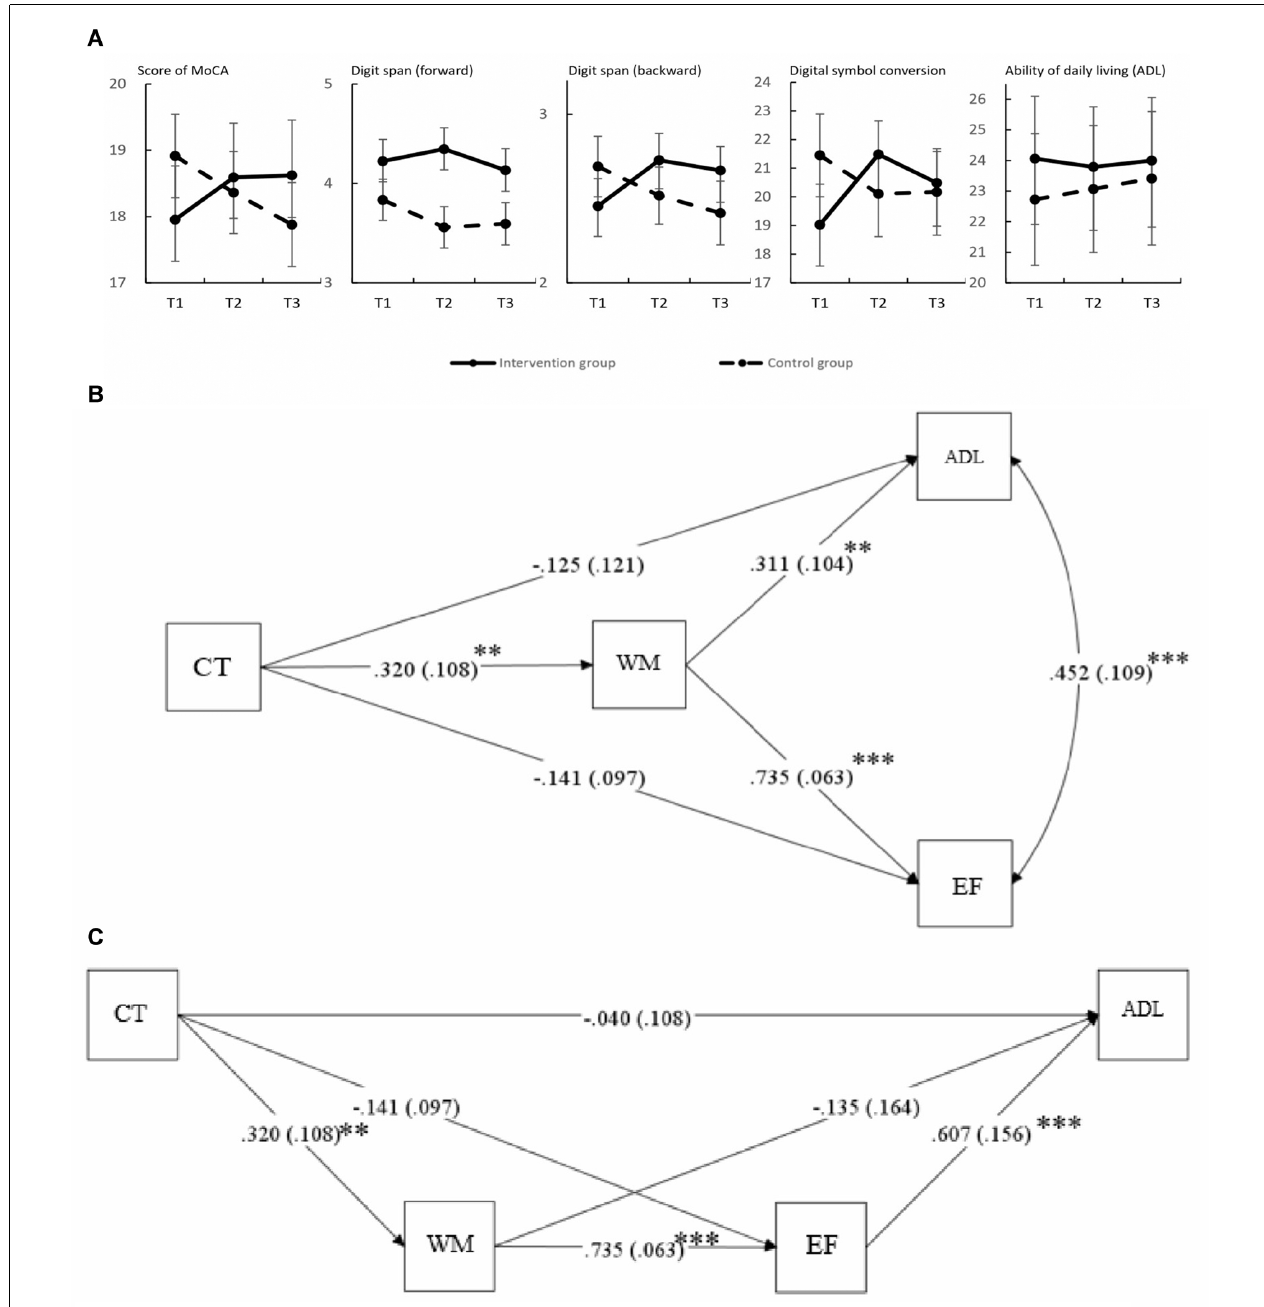
FIGURE 3 | (A) Evaluation score in T1, T2 and T3. From left to right, the ordinates represent the score of Montreal Cognitive Assessment (MoCA), digit span (forward), digit span (backward), digital symbol conversion and ability of daily living (ADL). (B) Mediating effect model of cognitive training (CT represents cognitive training, WM represents working memory, EF represents excusive function and ADL represents ability of daily living; ∗∗ p < 0.01, ∗∗∗ p < 0.001). (C) Mediating effect model of cognitive training (considering the relationship between executive function and ability of daily living; ∗∗ p < 0.01, ∗∗∗ p <